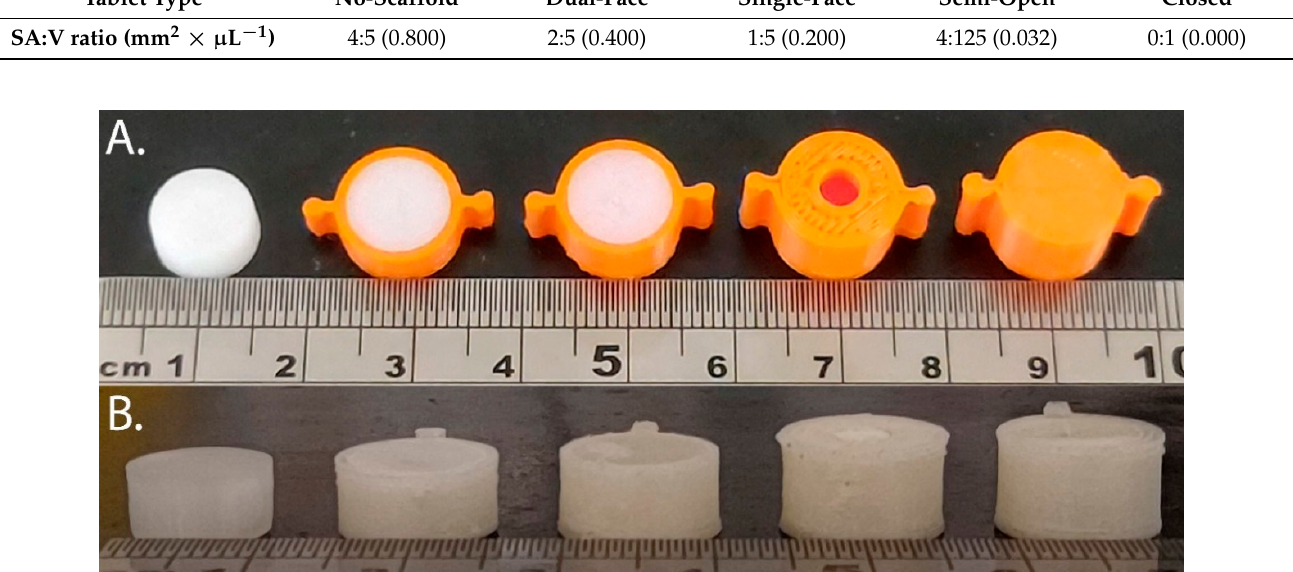
Table 6. List of decreasing SA:V ratios for respective tablet formats, in mm 2 × µ L − 1 .